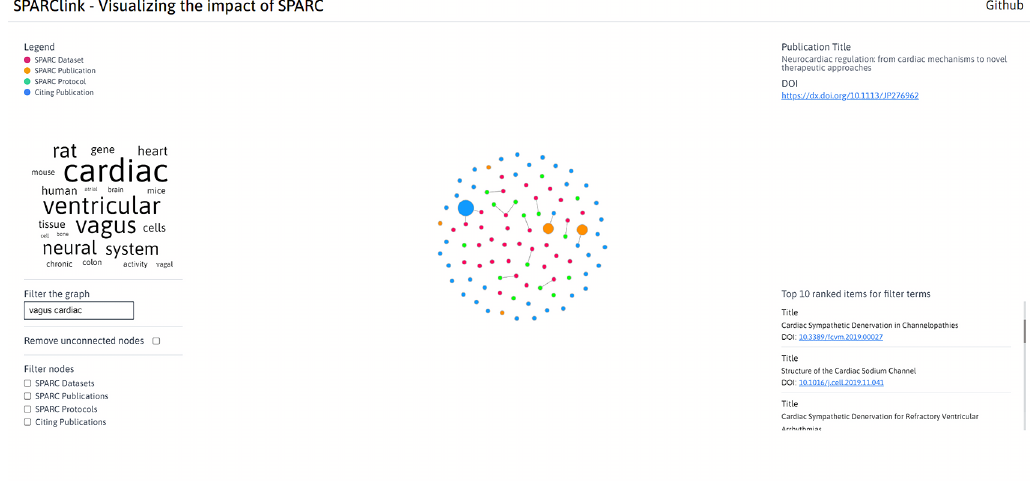
Figure 3. The design of the SPARClink webpage where results from the machine learning module are shown alongside the visualizations of SPARClink. The visualizations and the results in this figure have been filtered with the vagus and cardiac